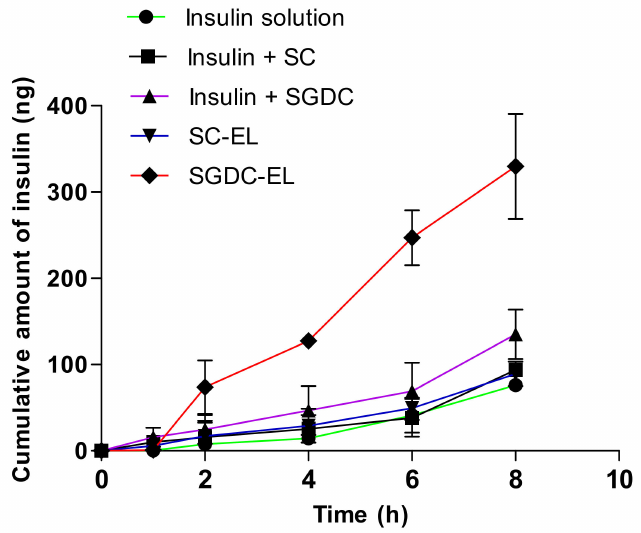
Figure 5. Permeability profiles of insulin-loaded elastic liposomes (SC-EL and SGDC-EL), and the combination of insulin and surfactants (insulin + SC and insulin + SGDC) across the porcine buccal tissues. All studies were performed from the donor to the receptor compartment in PBS buffer (pH 7.4) at 37 ◦ C. Data are presented as mean ± SD ( n = 3). Table 3. Permeation parameters that were calculated from the permeability studies of insulin-loaded elastic liposomes (SC-EL and SGDC-EL) and the combination of insulin and surfactants (insulin + SC and insulin + SGDC) across the porcine buccal tissues. Data are expressed as mean ± SD ( n = 3). *** p < 0.001 vs. insulin solution, ### p < 0.001 vs. SC-EL, and $$$ p < 0.001 vs. insulin + SGDC. J s , steady-state flux; K p , permeability coefficient; ER, enhancement ratio.